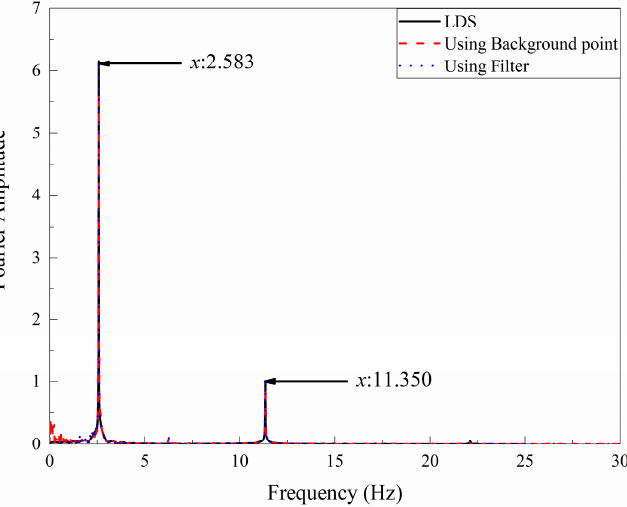
Figure 10. Frequency domain comparison of UAV monitoring time history with and without de- noising process.